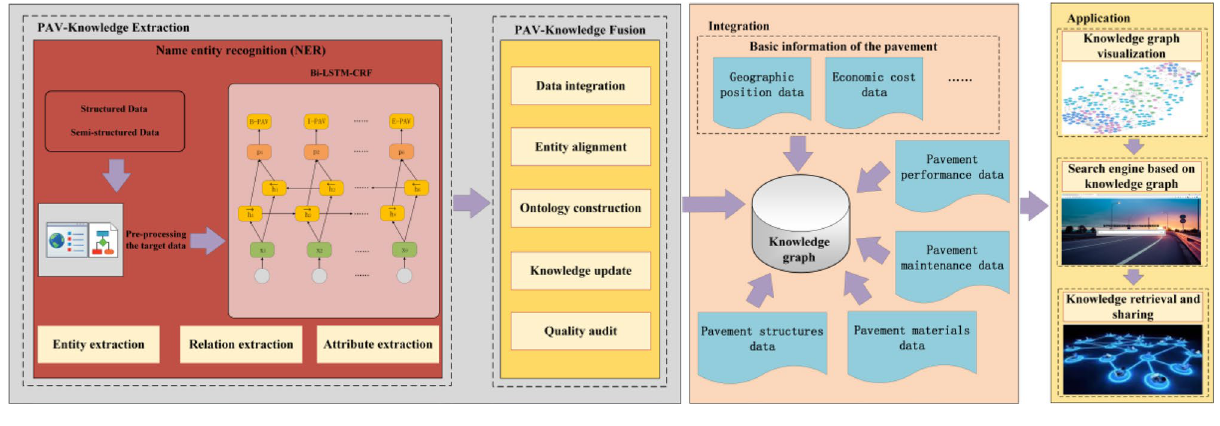
Figure 1. The technical route of the